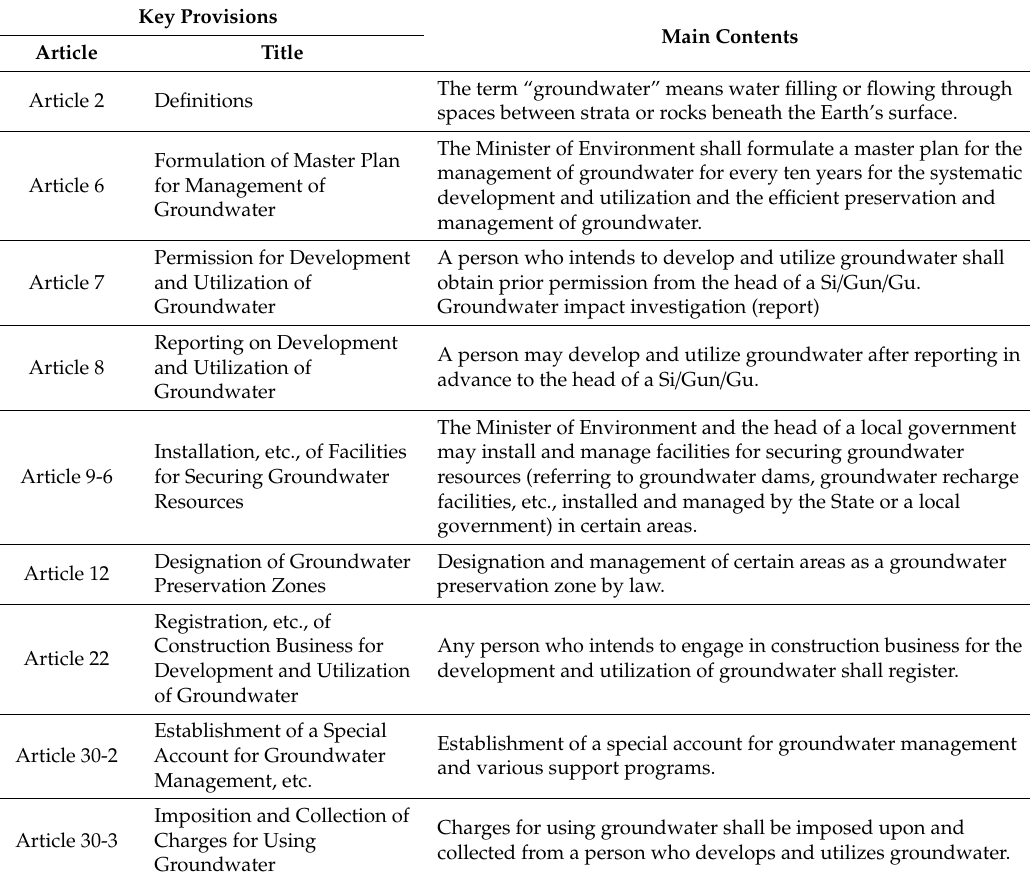
Table 1. Key provisions and contents related to the ASWQE projects in the Groundwater